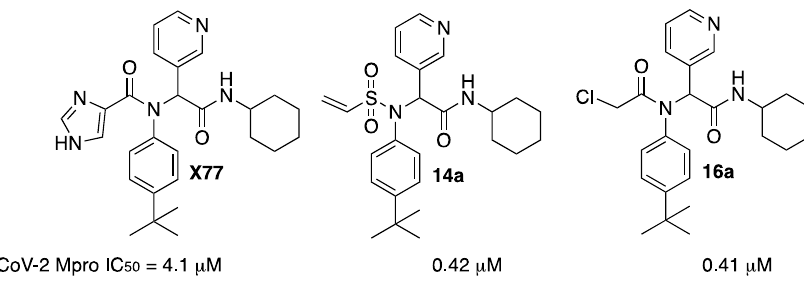
Figure 20. Inhibitors 14a and 16a derived from X77 .